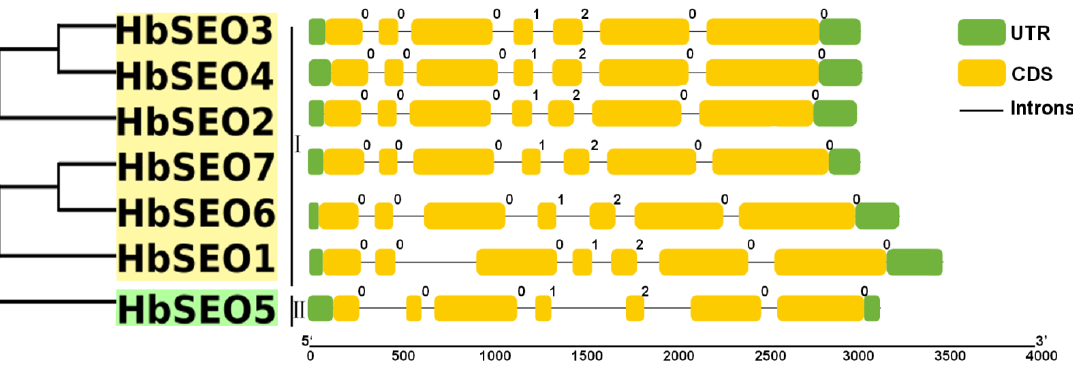
Figure 3. Gene structure of HbSEOs. The thick yellow boxes indicate CDS, the thick green boxes indicate UTR, and the black lines indicated introns.